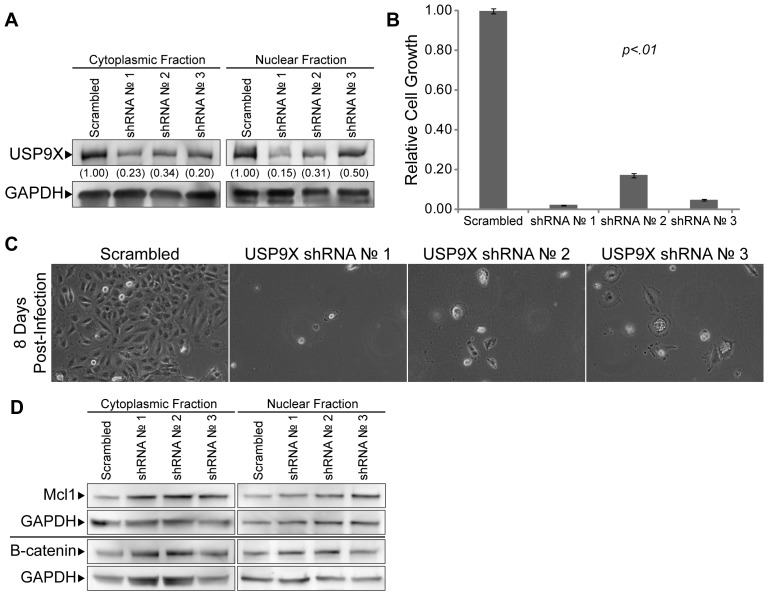
Knockdown of USP9X in DAOY MB.(A) Western blot analysis to verify the knockdown of USP9X in DAOY MB cells following infection with lentiviruses to introduce constitutively active shRNA against USP9X transcripts. Nuclear and cytoplasmic protein fractions were prepared 4 days after infecting cells with lentiviruses. USP9X levels are quantified, and levels in the Scrambled control are set to 1.00. (B) Cell growth was examined in triplicate by MTT assay 6 days after being plated at 104 cells per well of a 12-well plate. The data shown are averages relative to the Scramble control. Error bars represent standard deviation. P values were determined by student t-test and found to be <.01 for both USP9X shRNA 1, 2 and 3. (C) Photomicrographs of DAOY MB cells following knockdown of USP9X using lentiviral delivered shRNA constructs against USP9X transcripts. On day 0, cells were infected with USP9X shRNA lentiviruses. Beginning on day 1, infected cells were selected using puromycin for 48 hours. On day 4, cells were passaged into fresh culture flasks (5×105 cells per flask) and photographed on day 8 post-infection. (D) Western blot analysis of Mcl1, and β-catenin – targets of USP9X – in DAOY MB extracts used in Figure 6A.